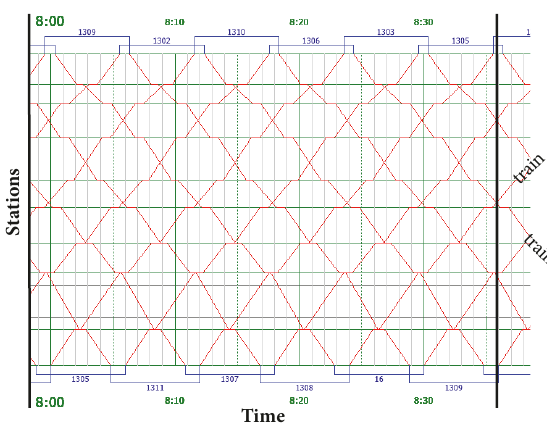
Figure 1: An example of the train